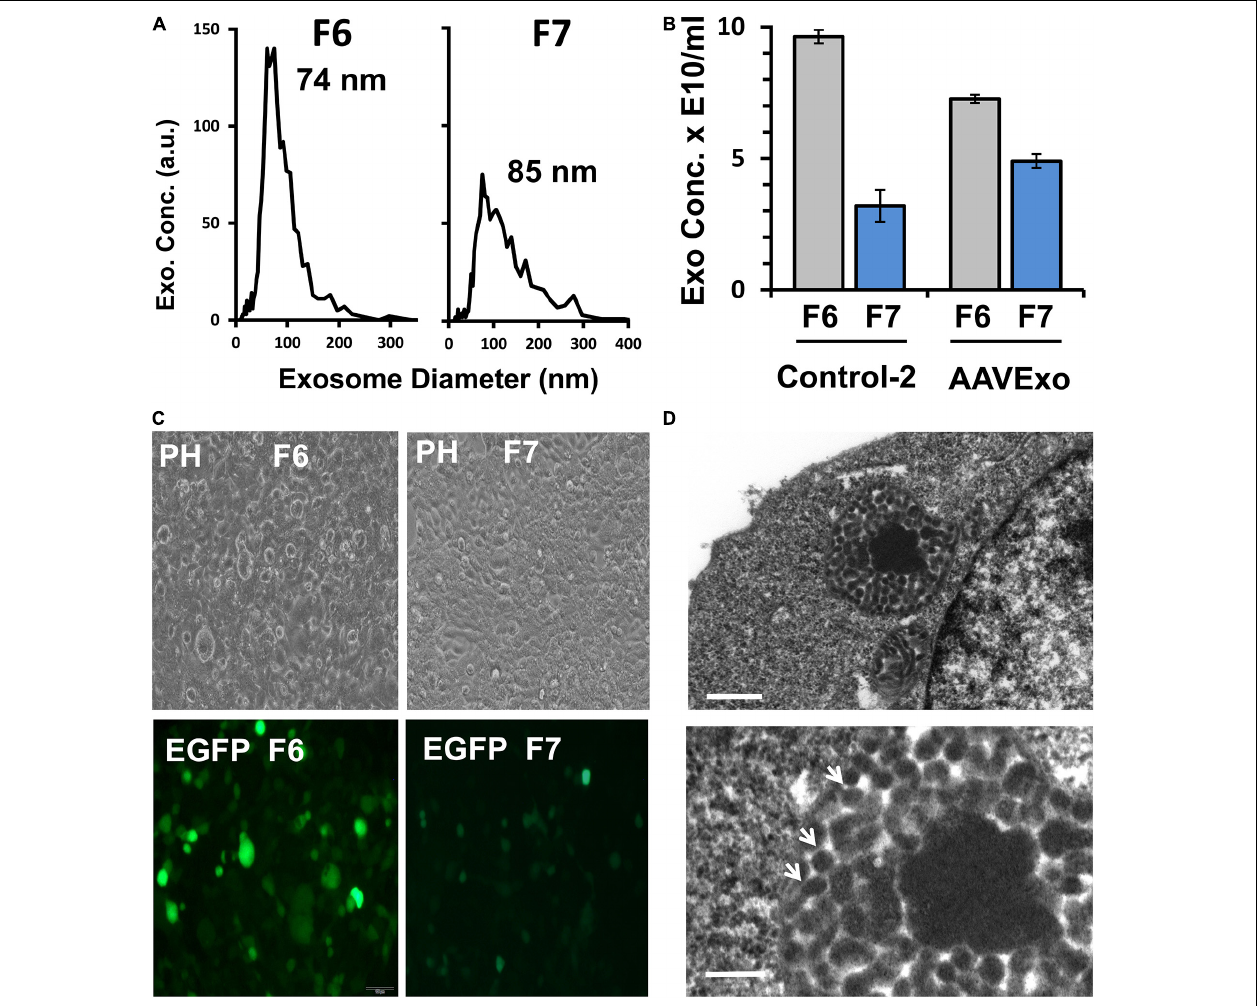
FIGURE 3 | Fraction 6 has the major amount of clean AAVExo compared to fraction 7. (A) Exosome size distribution in F6 and F7 of AAVExo measured by ZetaView. Three replicates were conducted, and a representative was shown. (B) Exosome concentration of F6 and F7 in control 2 and AAVExo measured by ZetaView. The graph was plotted by the mean of three biological replicates with bars showing the standard deviations. (C) F6 but not F7 has effective transduction capacity in vitro . HEK 293T cells were treated with the same titer of AAV6Exo-EGFP F6 or F7 for 5 days. EGFP was detected by fluorescence microscopy. Three biological replicates were performed, and a representative was shown. (D) AAV-containing exosomes in multivesicular body. AAV-producing cells were imaged by TEM, and AAV particles were observed in exosomes prior to secretion. Lower panel represents the zoom-in area of upper panel. Scale bar: upper panel, 500 nm; lower panel, 200